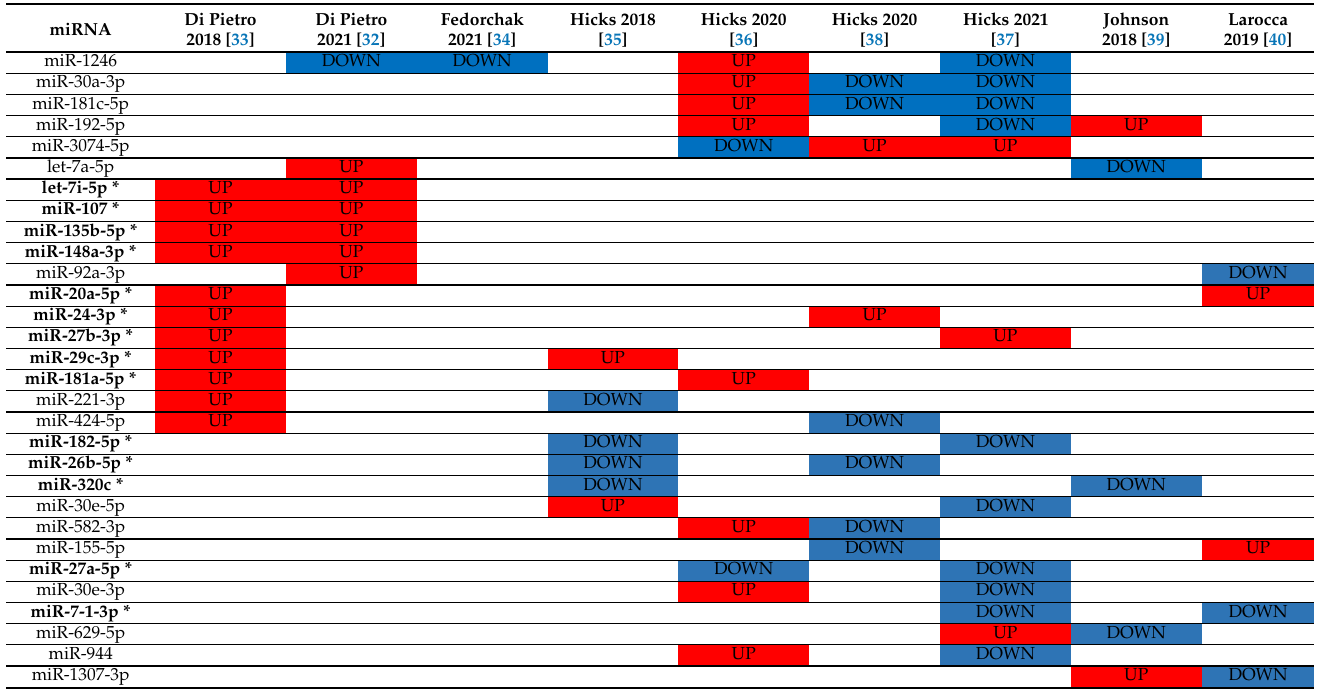
Table 2. Prevalence and direction of change for miRNAs appearing in multiple